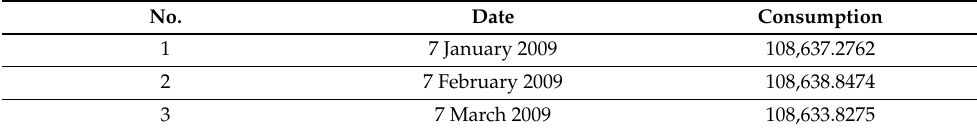
Table 4. Sample records from water consumption dataset.